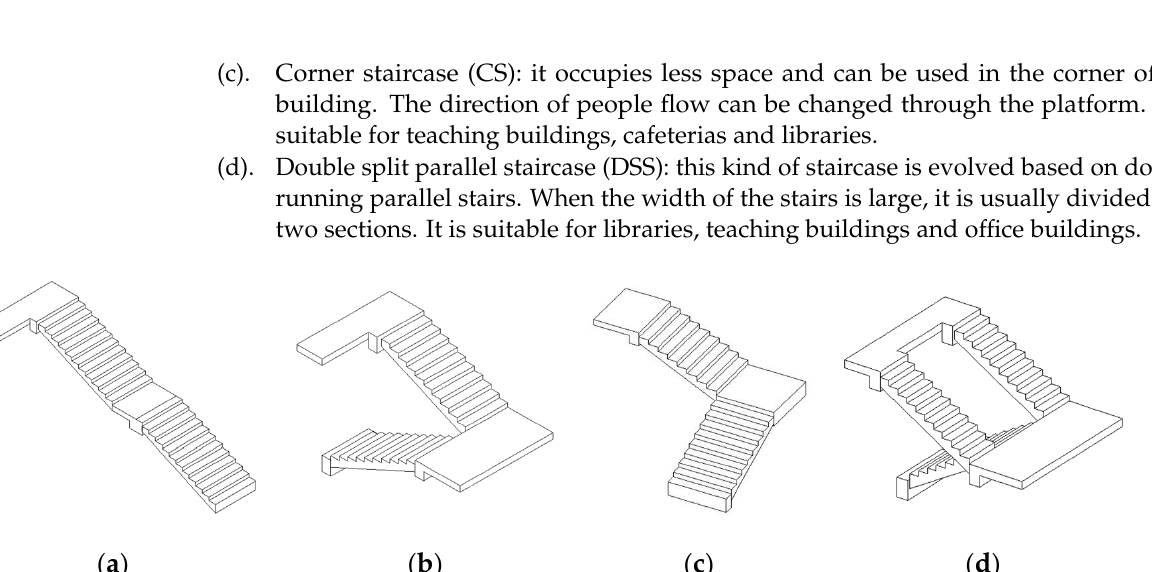
Figure 1. Four types of common staircases. ( a ) Straight running stairs with platform (SSP); ( b ) double running parallel stairs (DPS); ( c ) corner stairs (CS); ( d ) double split parallel stairs (DSS).